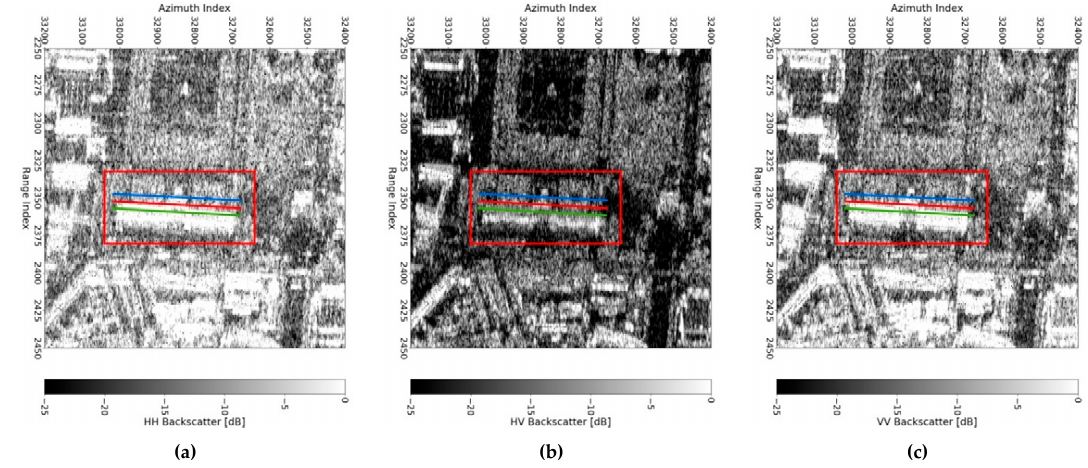
Figure 5. Quick look intensity images of the ROI for all polarizations: ( a ) HH, ( b ) HV and ( c ) VV. The ROI is specified through a red rectangle, whereas the tomograms presented afterward correspond to the lines crossing the ROI.